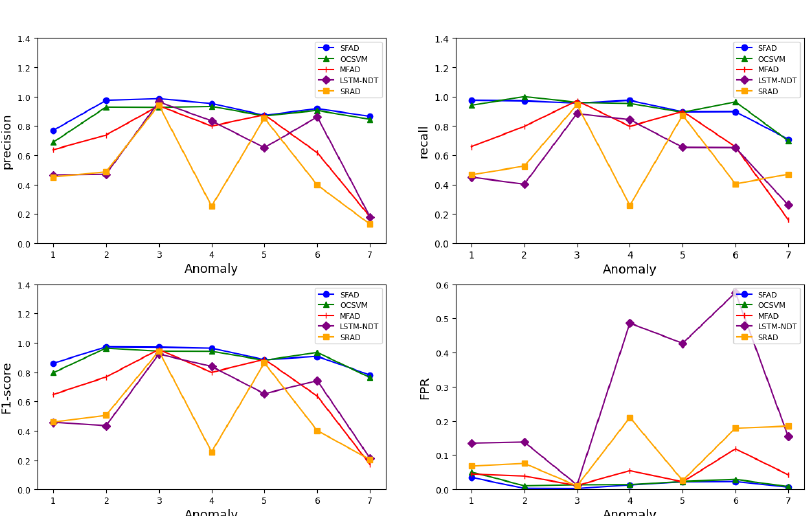
Figure 8. Evaluation indicator comparison of anomaly detection methods.